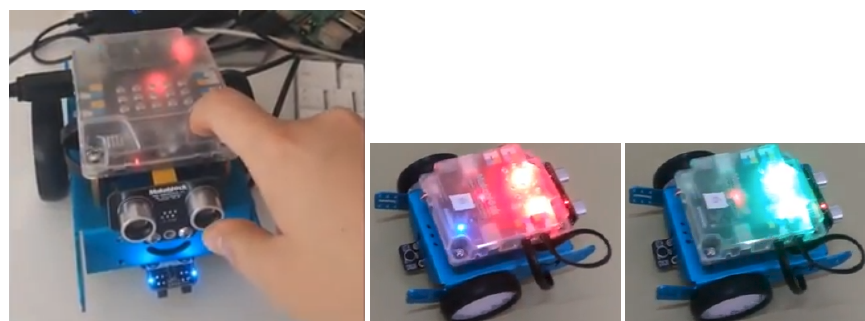
Figure 5. Practice tasks with mBot to operate the push button and LED, and the microphone with LED to recognize sounds.